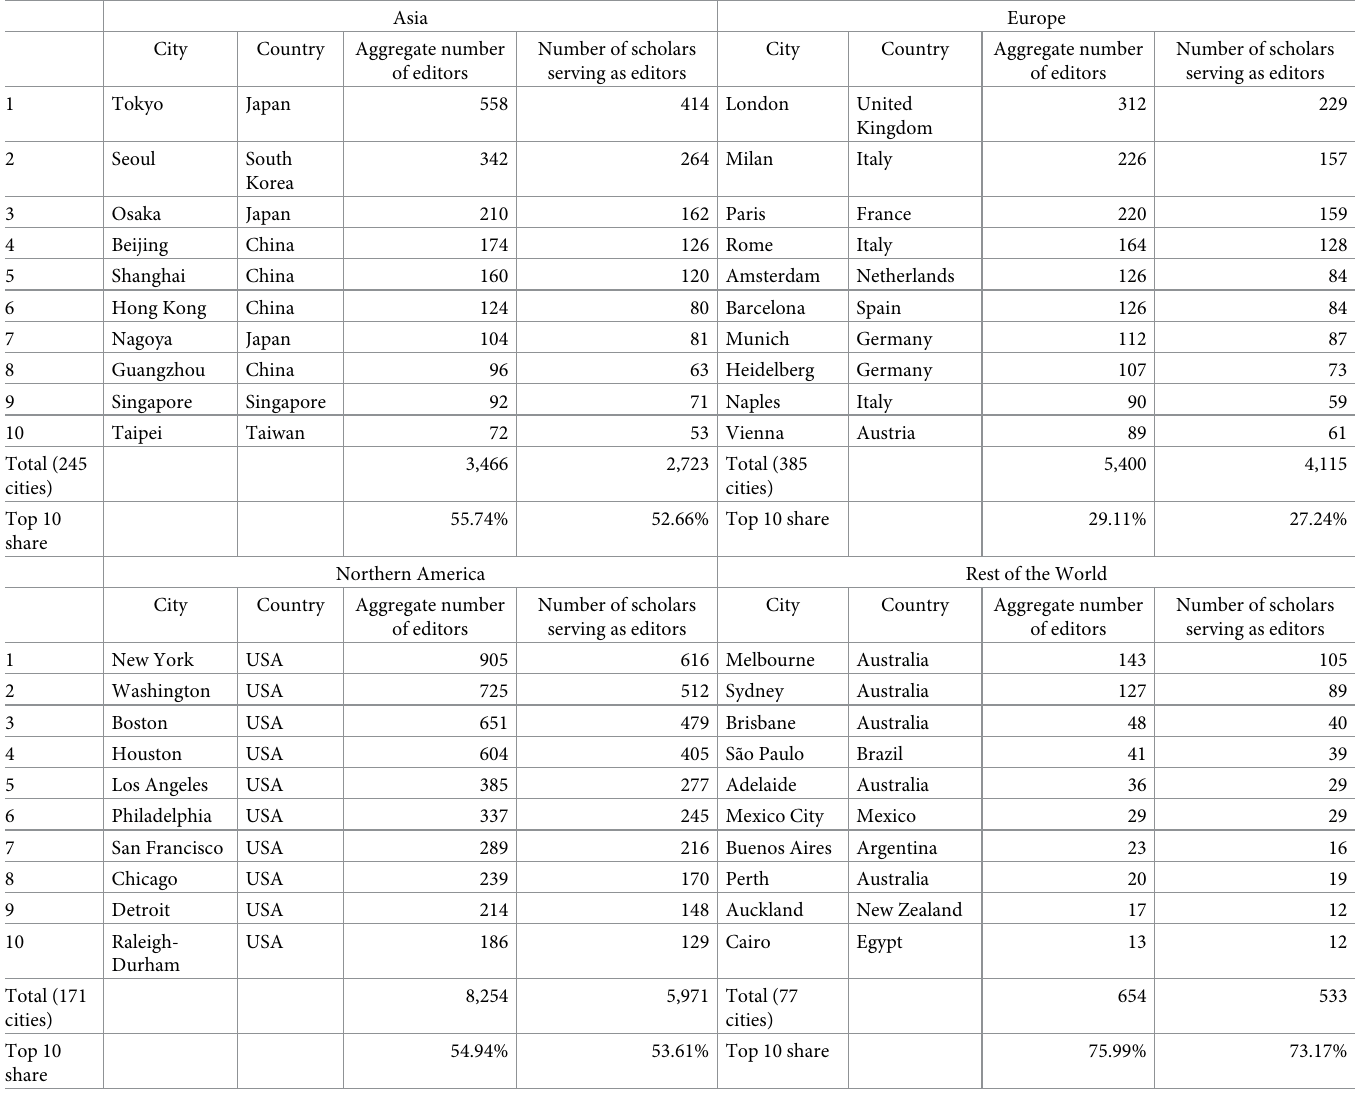
Table 1. Top-10 cities in terms of editors and scholars by